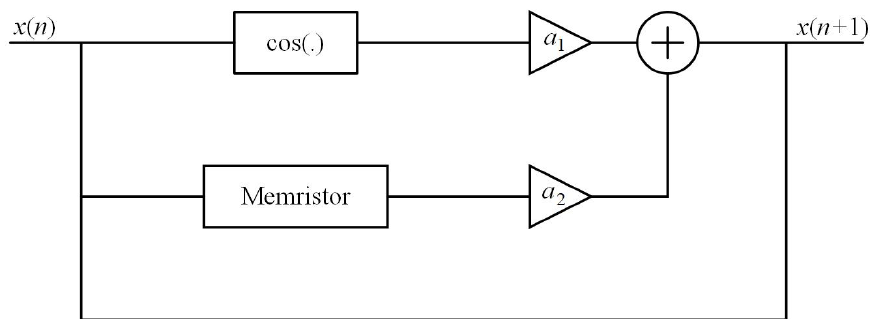
Figure 2. The map built with a cosine function cos ( . ) and a memristor with discrete memristance M ( y ( n ))